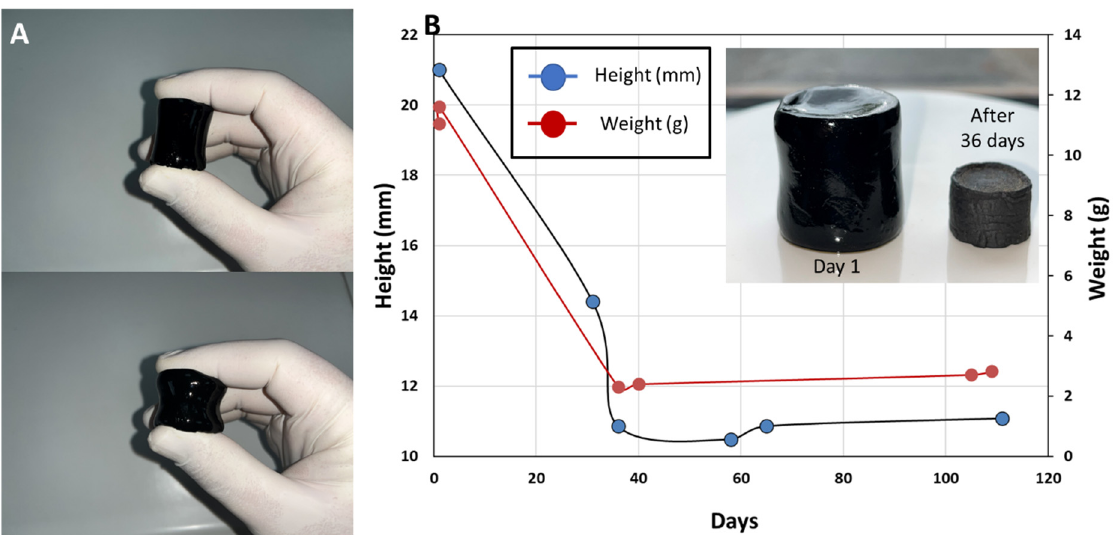
Figure 3. ( A ) Photographs showing the PANi/PVA hydrogel after synthesis, which can be compressed by light squeezing between two fingers. ( B ) Graph depicting the shrinkage in the height of the cylindrical PANi/PVA hydrogel specimen (photograph in the inset) with time, as well as the weight change with time, and its transformation into a rubber-like material after drying at room temperature and ambient conditions.